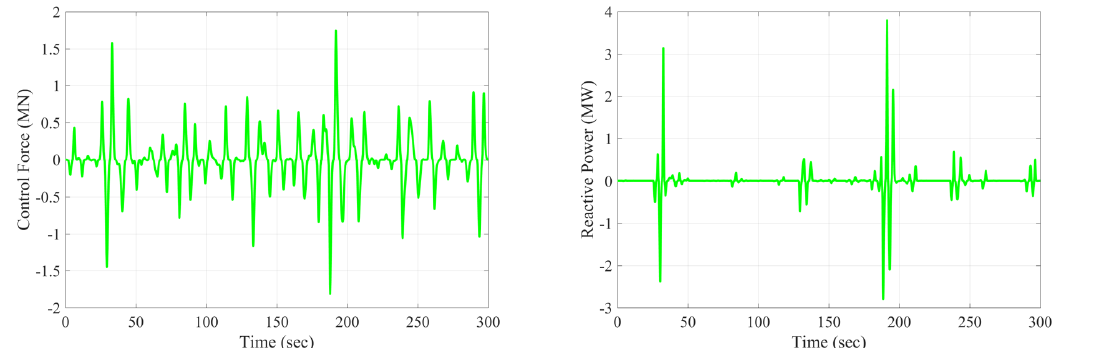
Figure 21. SS4 control force ( left ) and reactive power ( right ),